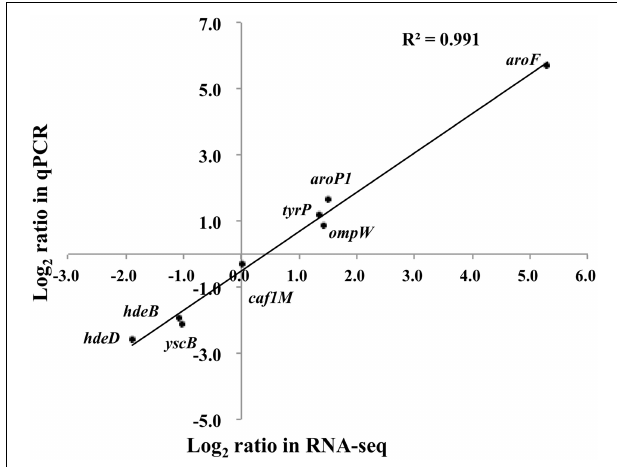
FIGURE 4 | Transcription measurements of eight genes were chosen for quantitative RT-PCR validation. The real-time PCR log 2 values were plotted against the RNA-seq data log2 values. The coefficient of determination ( R 2 ) for comparison of the two datasets is 0.991.